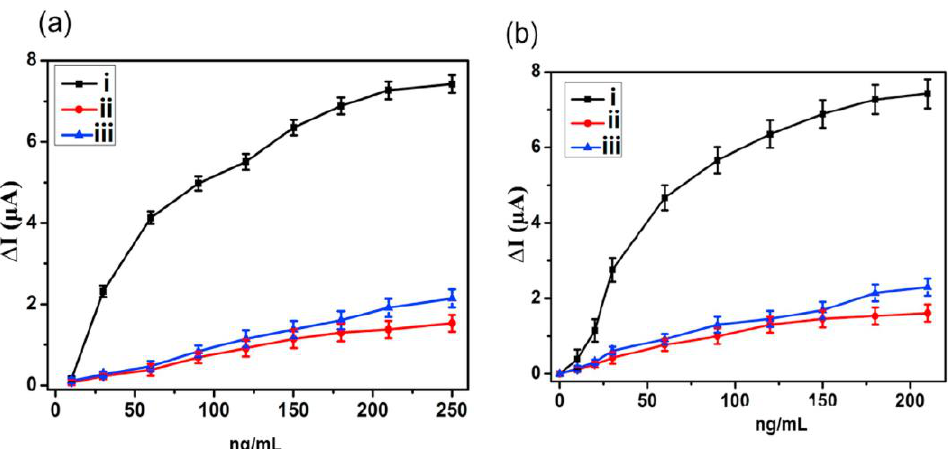
Figure 5. ∆ I as a function of i: ∆ 9 -THC, ii: caffeine, and iii: acetaminophen utilizing ( a ): carbon beads/MIPs electrode and ( b ): CNT/MIP electrode. Reprinted and adapted with permission from ref. [50]. Copyright 2019